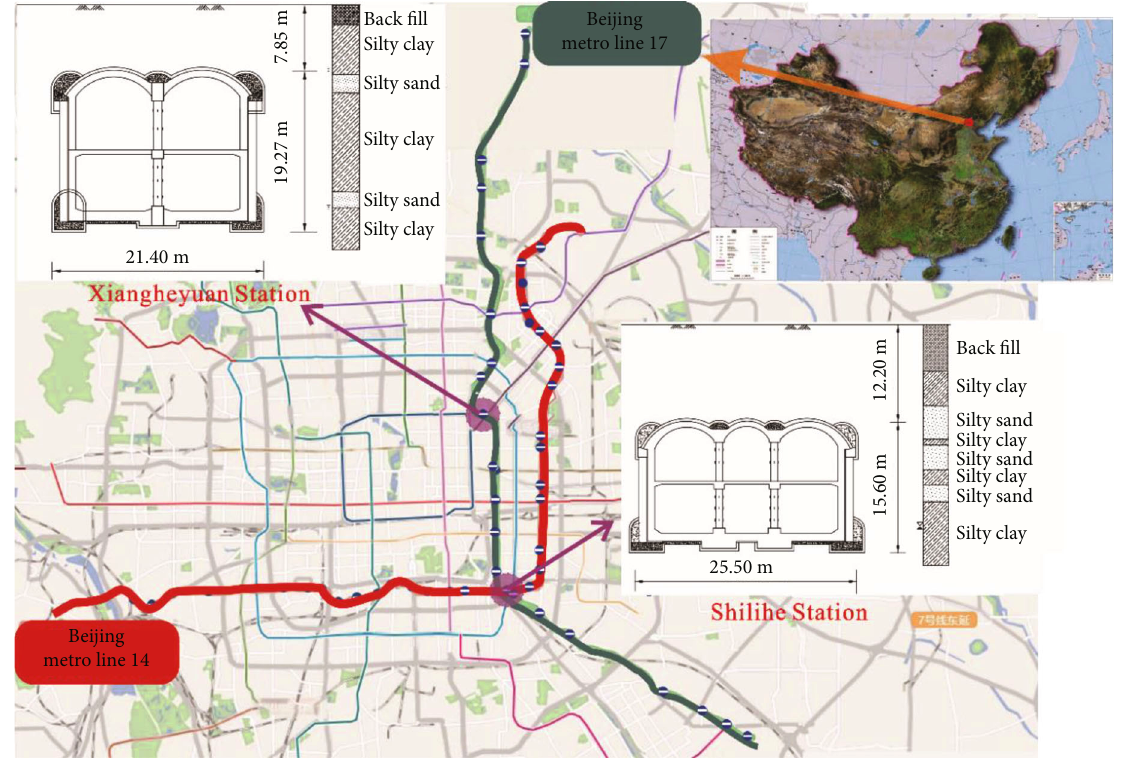
Figure 1: Location and geological structure section of Xiangheyuan station and Shilihe